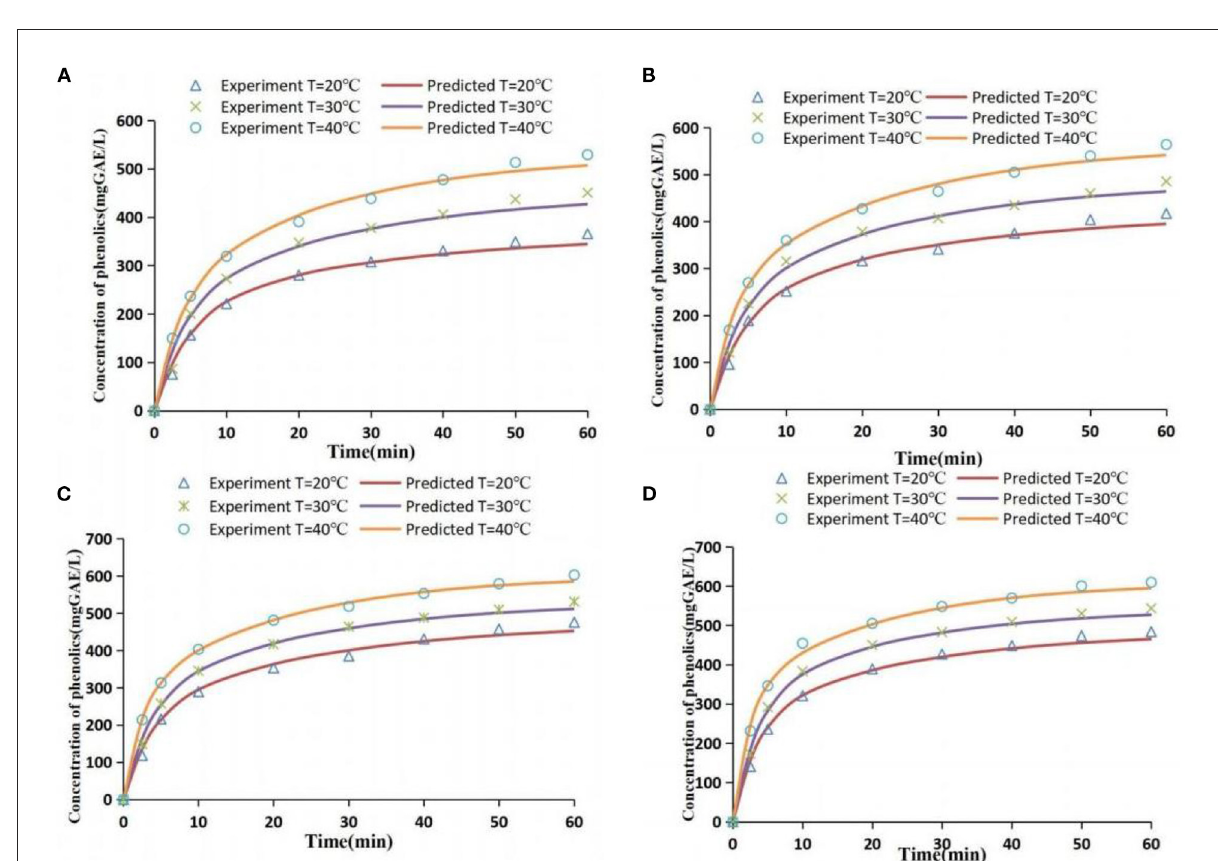
FIGURE7 Comparison of experimental values and simulated values [extraction conditions: (A) 41.1 W/L; (B) 63.5 W/L; (C) 96.1 W/L; (D) 111.2